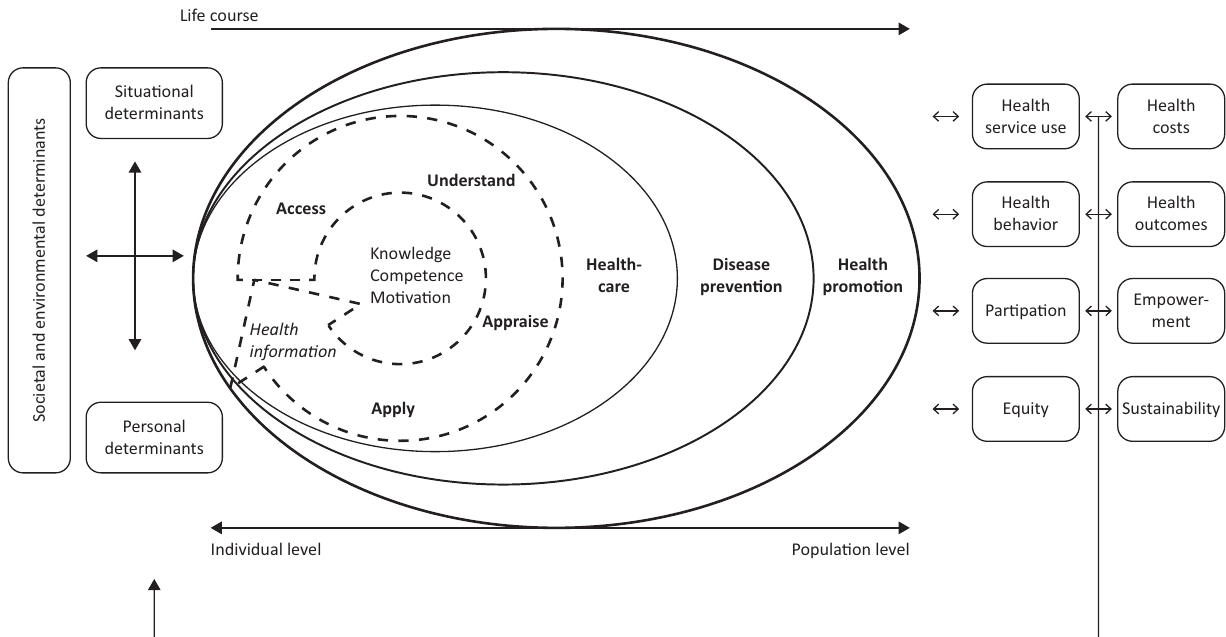
Figure 2. Sørensen et al.’s integrated model of health literacy (2012; with courtesy of Dr. Sørensen). The KPIs for disease-specific health literacy in the fol- lowing stage are related to KIPs for digital literacy, as the communities’ health knowledge level will only in- crease as people in the communities are accessing the digital health messages in the community information spots, either with their own smartphones or with the tablet devices in the spots. Knowledge scores for each domain will be calculated individually and at the village level, and comparisons between the groups will be per- formed. The preliminary results from the first stage indi- cate that disease-specific health literacy scores, in almost all domains, increases after the participant has been ex- posed to the digital health messages once. In the follow- ups, during the assessment of knowledge retention, both health knowledge and the actual use of the information spots will be assessed. These results will be valuable in light of digital literacy, as the users will have to manoeu- vre single-handedly and digitally in the information